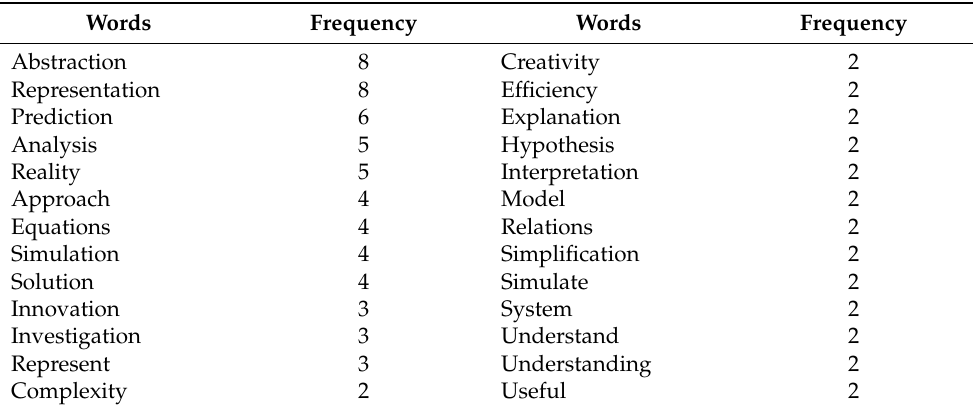
Table 5. Words related to modeling concept and their frequency.